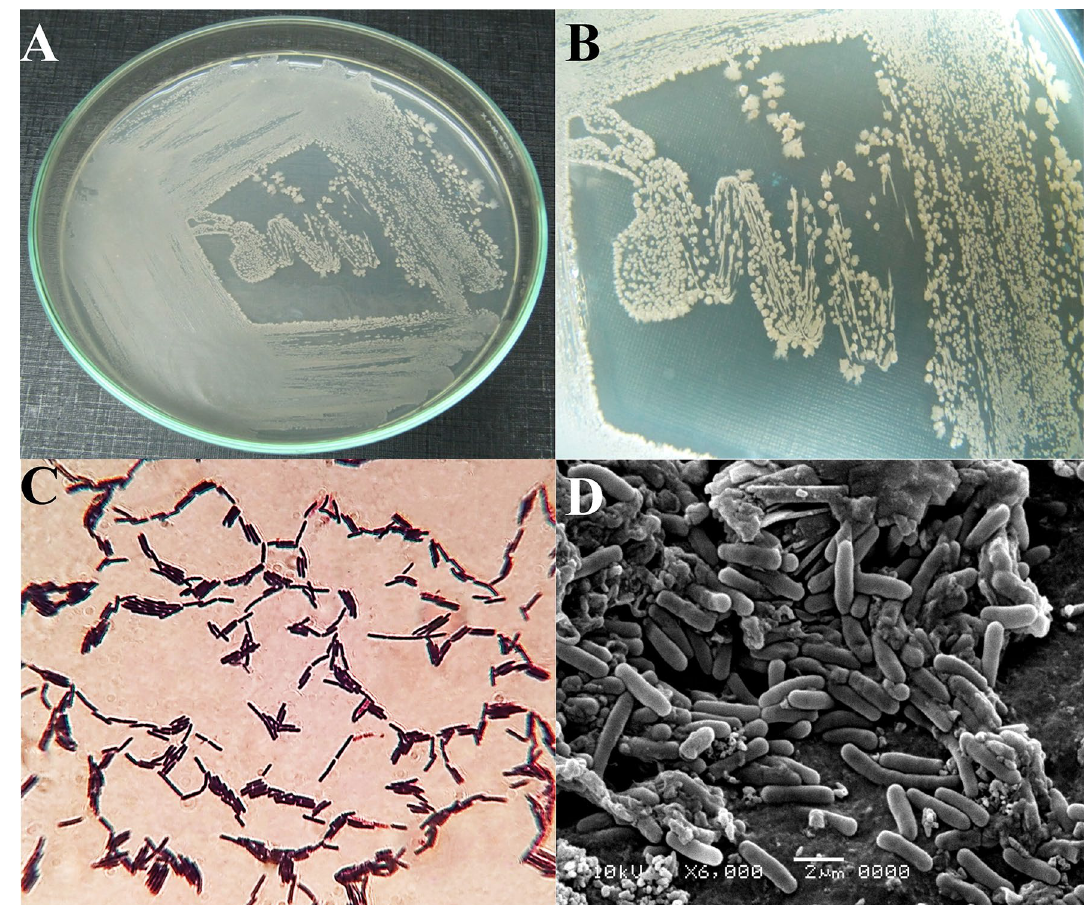
Figure 2. ( A , B ) Cultural characteristics of strain SEE-3 grown on nutrient agar plates. ( C ) Gram stain test shows Gram-positive bacilli. ( D ) Scanning electron micrograph showing cell morphology of strain SEE-3 at magnification of 6000